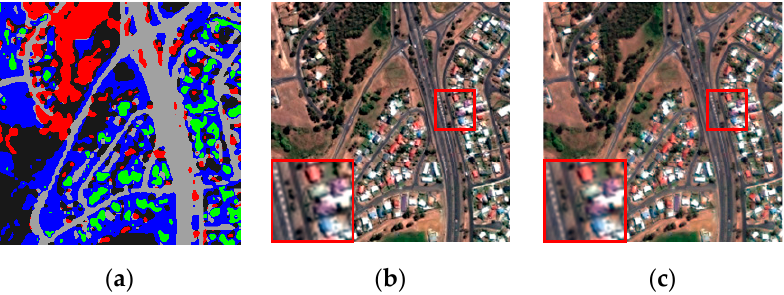
Figure 4. Segmentation and fusion results of example data from the GeoEye-1 satellite: ( a ) segmentation result by k-means; ( b ) fusion result of method without segmentation; and ( c ) fusion result based on cooperation with segmentation.